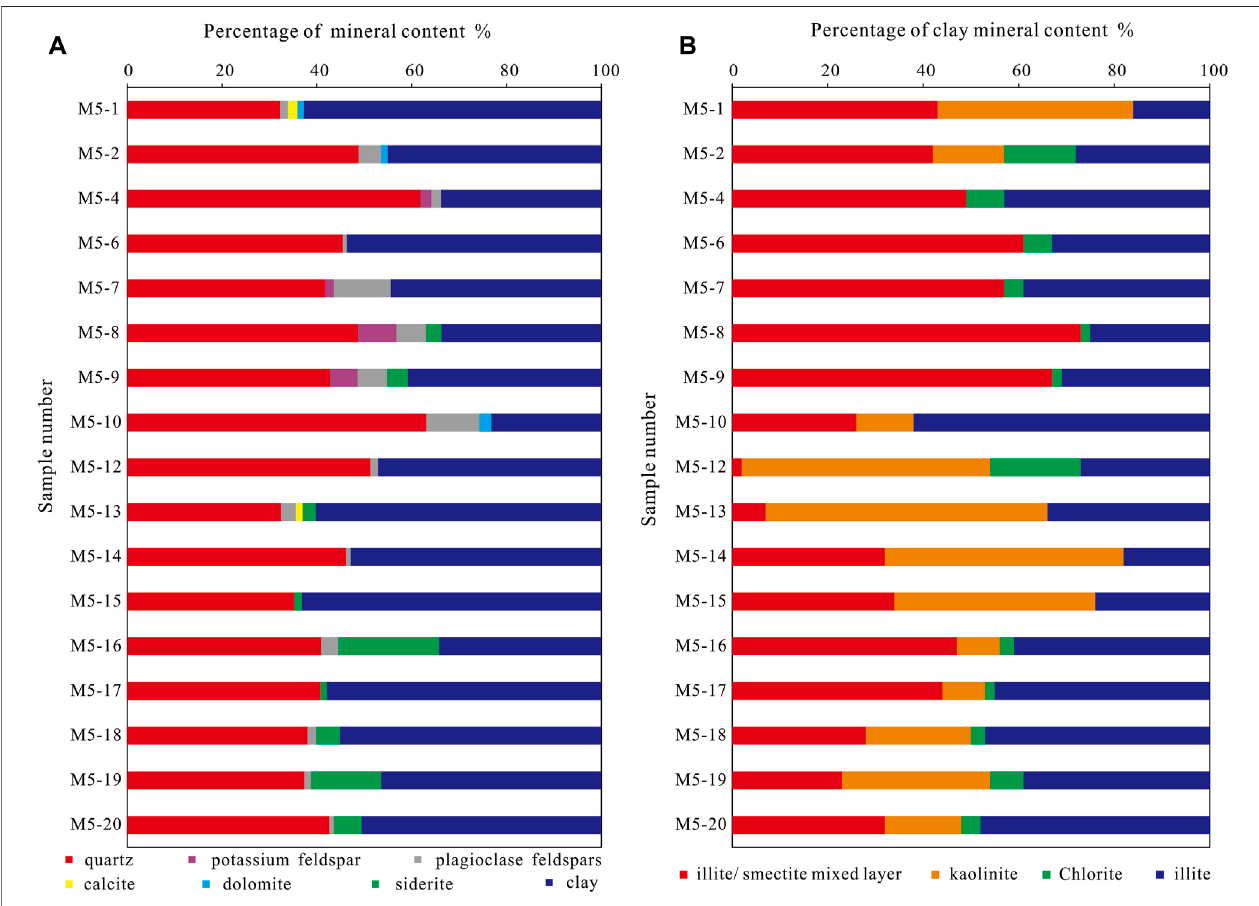
FIGURE 2 | Content of mineral components in samples with different lithologies. (A) percentage of mineral content; (B) percentage of clay mineral content.